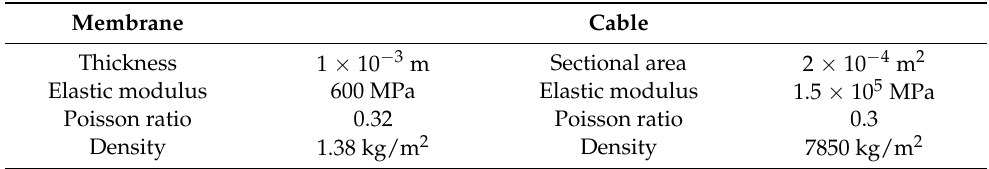
Table 3. Material properties of the finite element